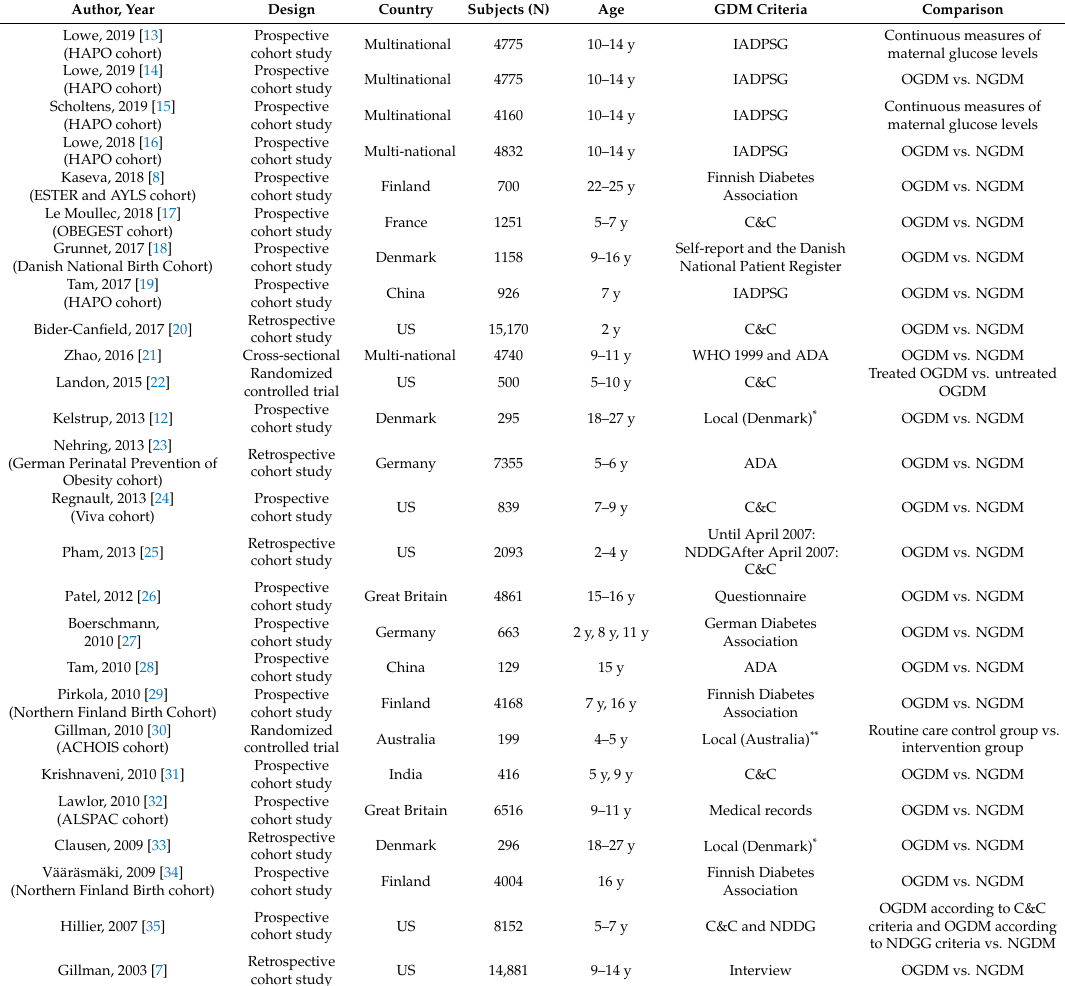
Table 1. The characteristics of included